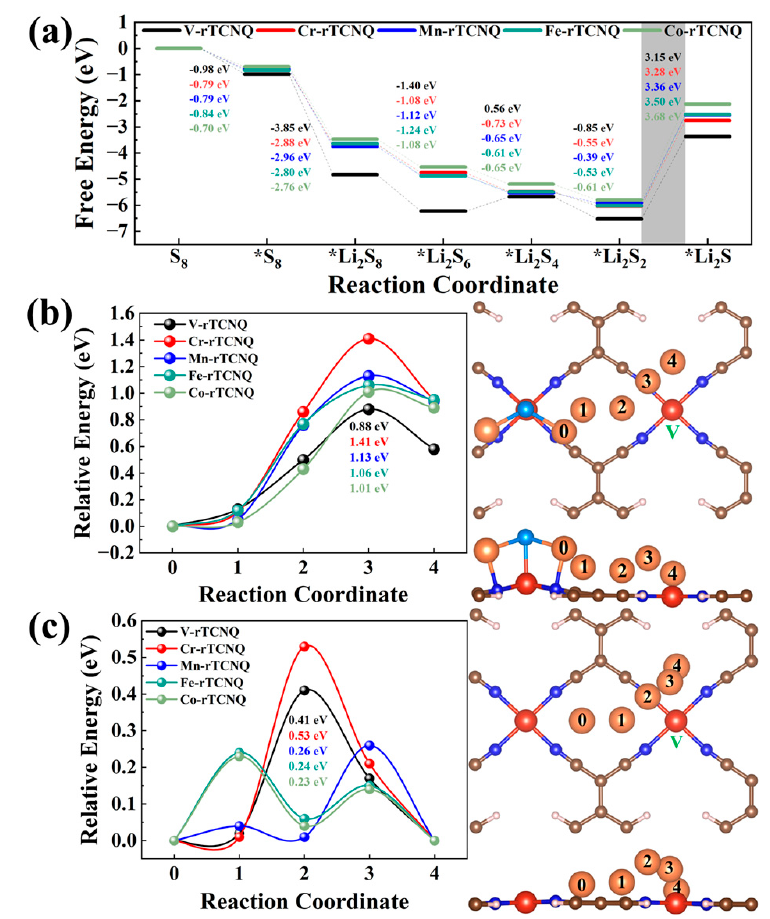
Figure 4. ( a ) The Gibbs free energy ladder diagram of SRRs process of V-rTCNQ, Cr-rTCNQ, Mn- rTCNQ, Fe-rTCNQ and Co-rTCNQ structures. ( b , c ) The relative energy profiles of TM-rTCNQ (TM = V, Cr, Mn, Fe and Co) and migration path of Li 2 S decomposition or Li-ion diffusion on V-rTCNQ, respectively. Table 1. The RLS and Li 2 S dissociation barrier of V/Mn-rCTNQ and other SACs in some recent literatures.